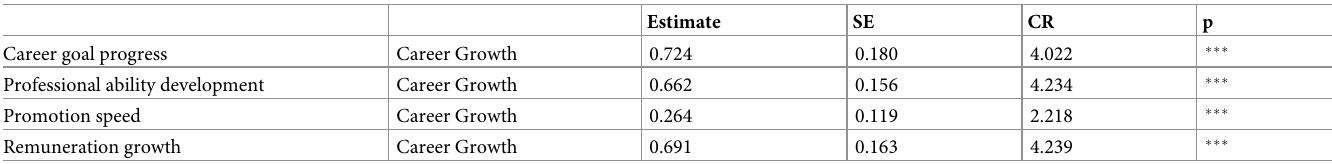
Table 9. Regression